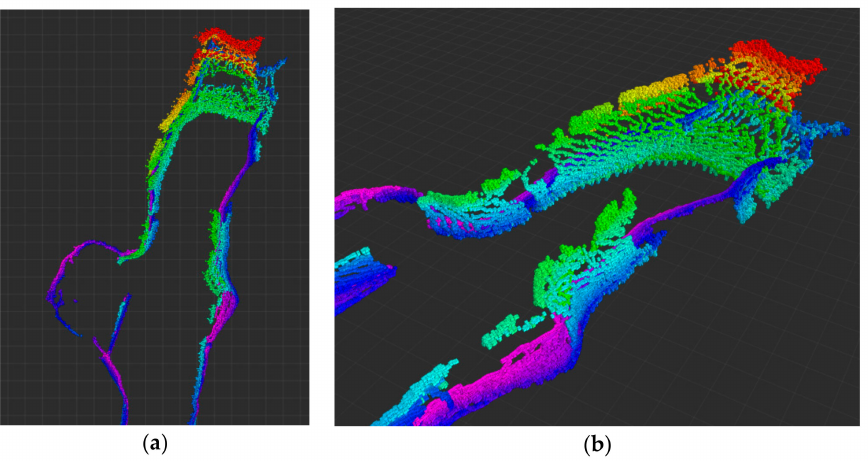
Figure 26. Example of the scanning obtained while the LHD is approaching an extraction point. ( a ) Top view of the pile reconstruction. ( b ) Isometric view of the pile